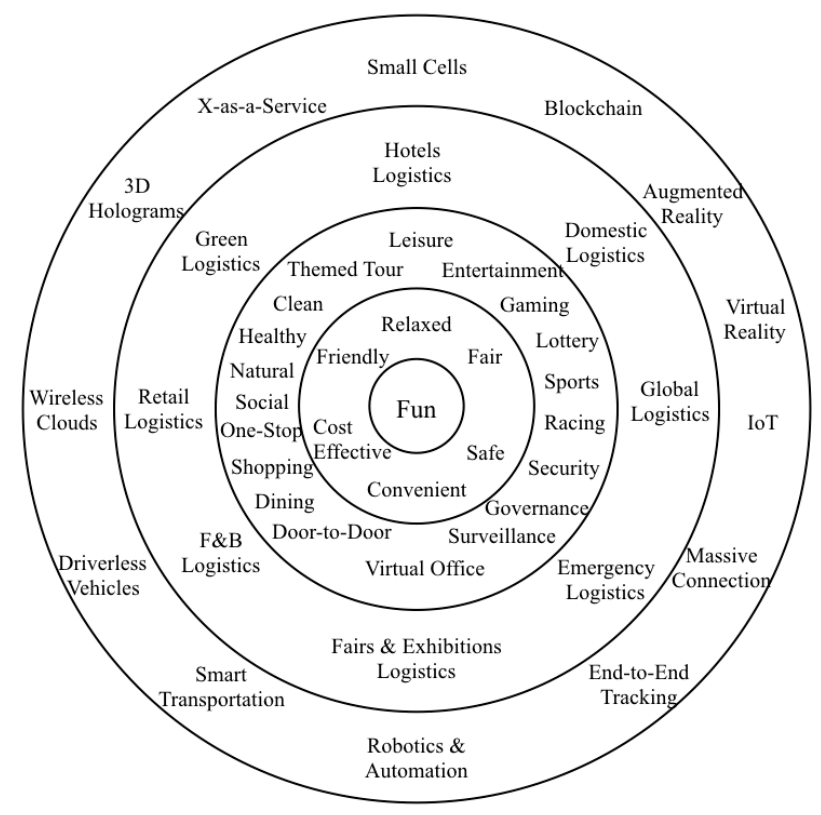
Figure 3. ICE CVC model for blockchain in ICE logistics.